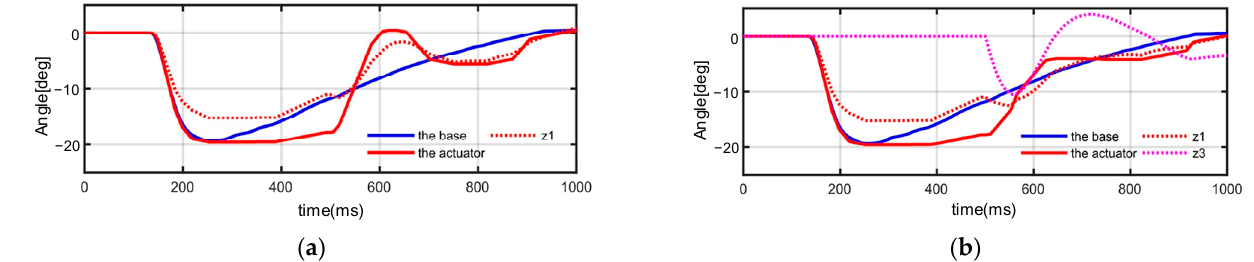
Figure 8. The effect of the correction by z 3 in suppressing the overshoot: ( a ) compensated by PD; ( b ) adding the correction by z 3 .